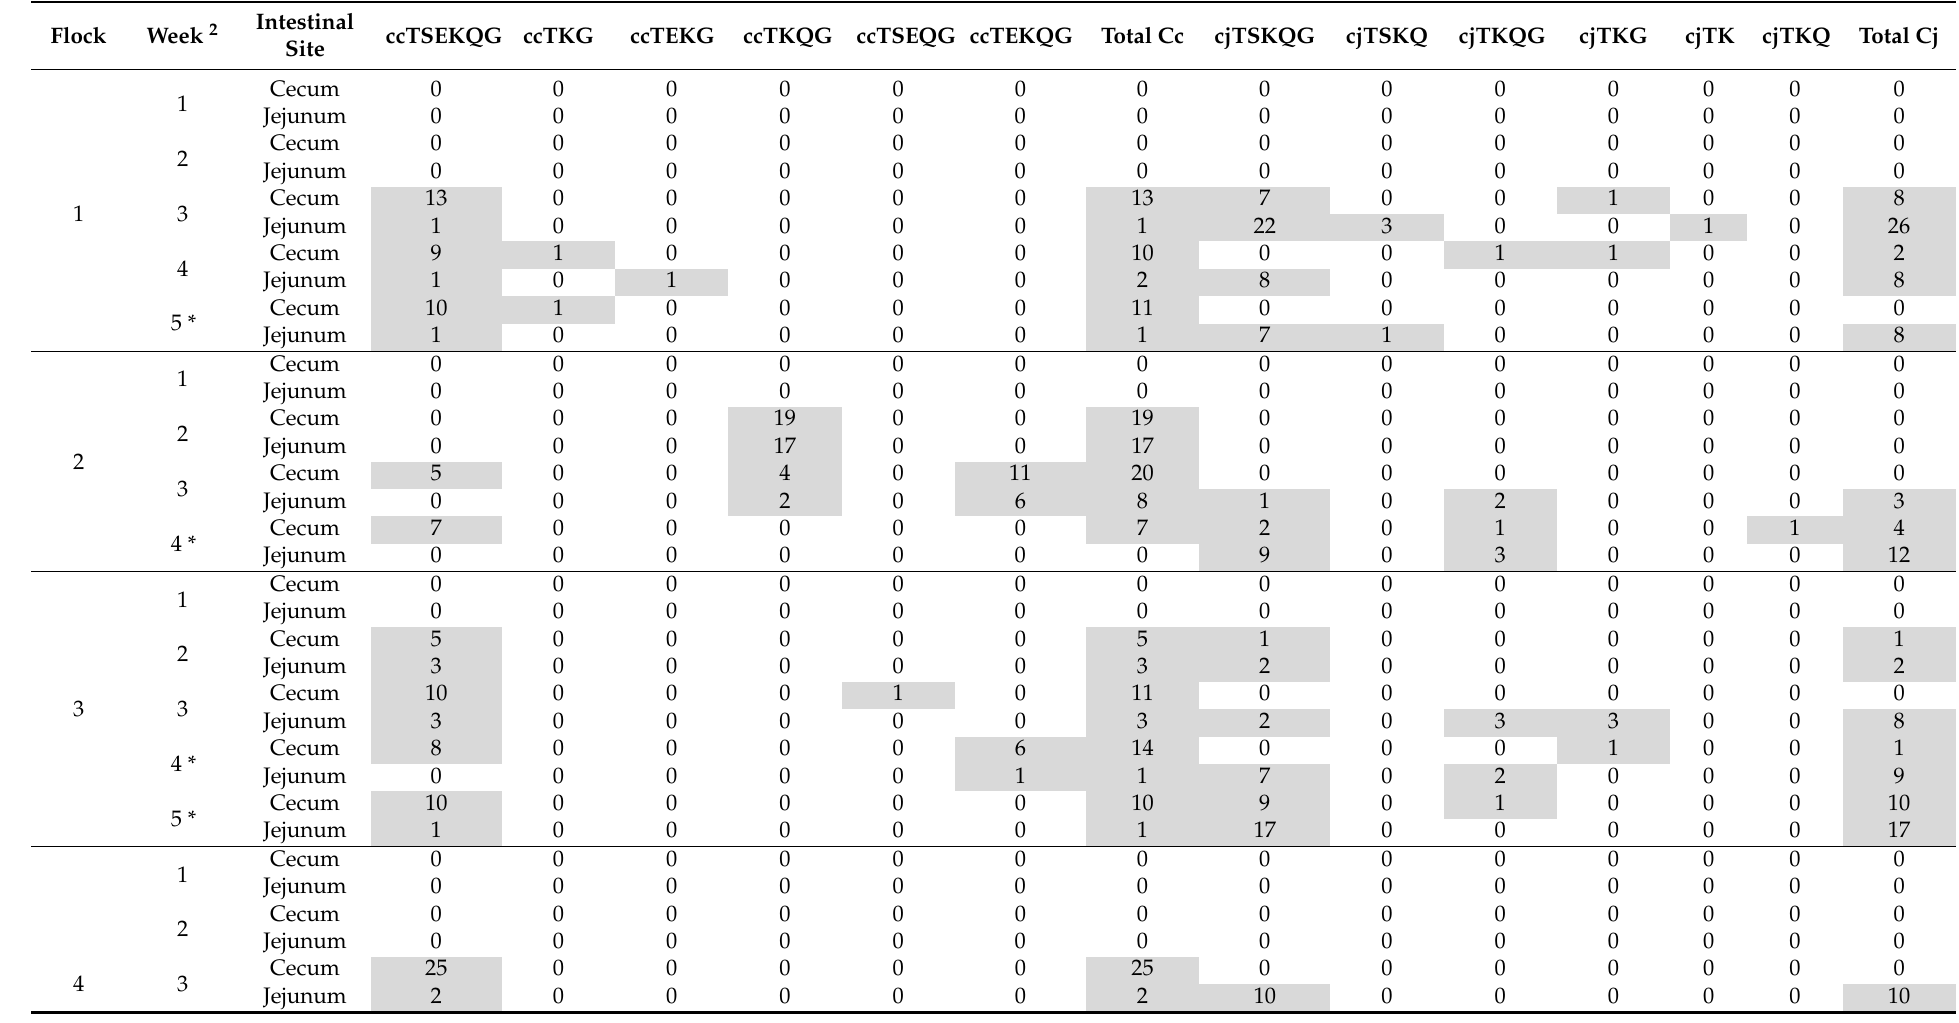
Table 2. Distribution of Campylobacter species and AMR profiles in the cecum and jejunum from the four turkey flocks. Campylobacter Species/AMR profiles 1